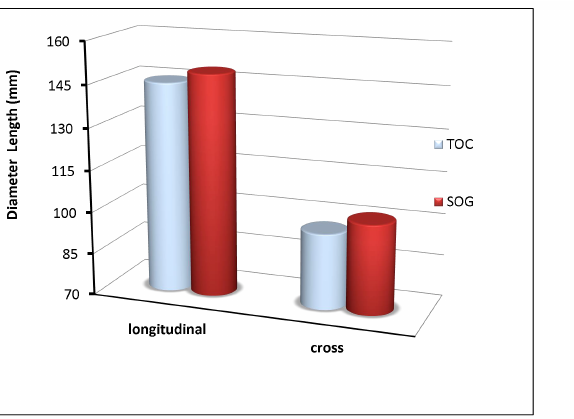
Figure 9. Average longitudinal diameter and cross diameter of the proposed SOG and TOC. The amount of irrigation water needed throughout the season of SOG and TOC is shown in Figure 10. Saving the consumed amount from irrigation is important, especially in areas without rivers and suffering from water poverty; thus, more savings are better.